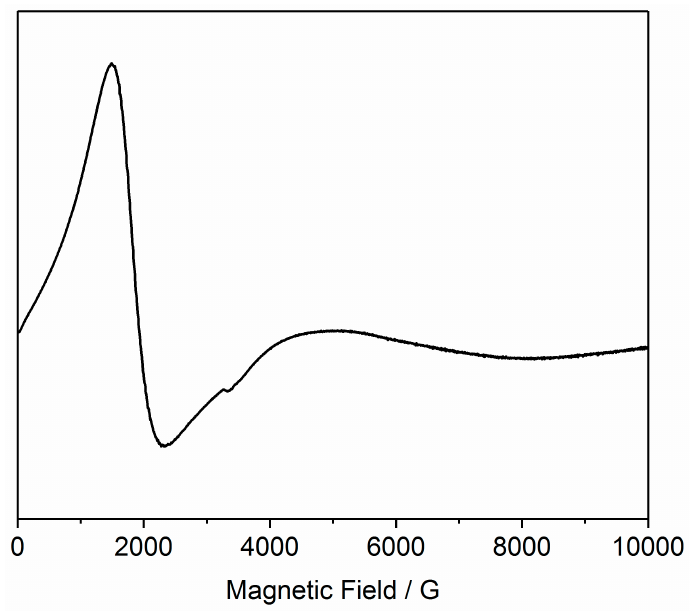
Figure 6. X-band ( ca . 9.4 GHz) EPR spectrum of a powdered sample of ( 1 ) at 5 K.